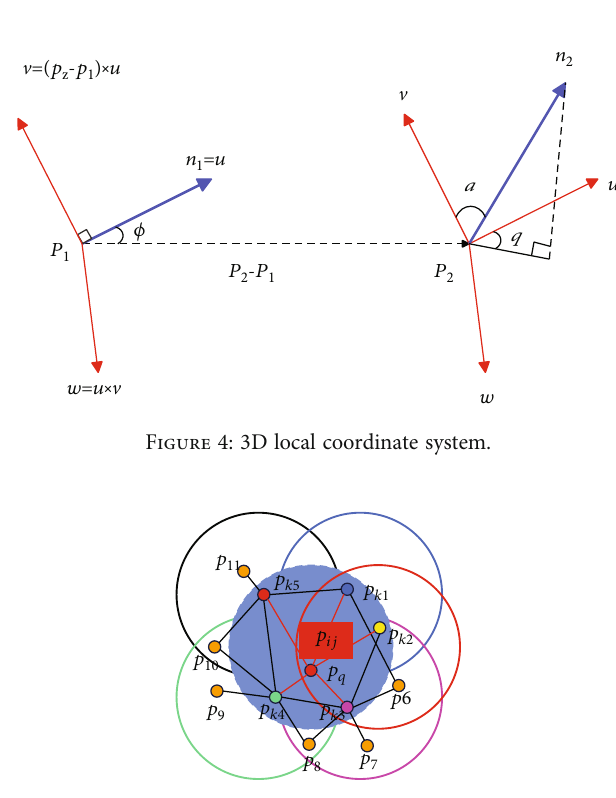
Figure 5: Schematic diagram of FPFH weight relationship.